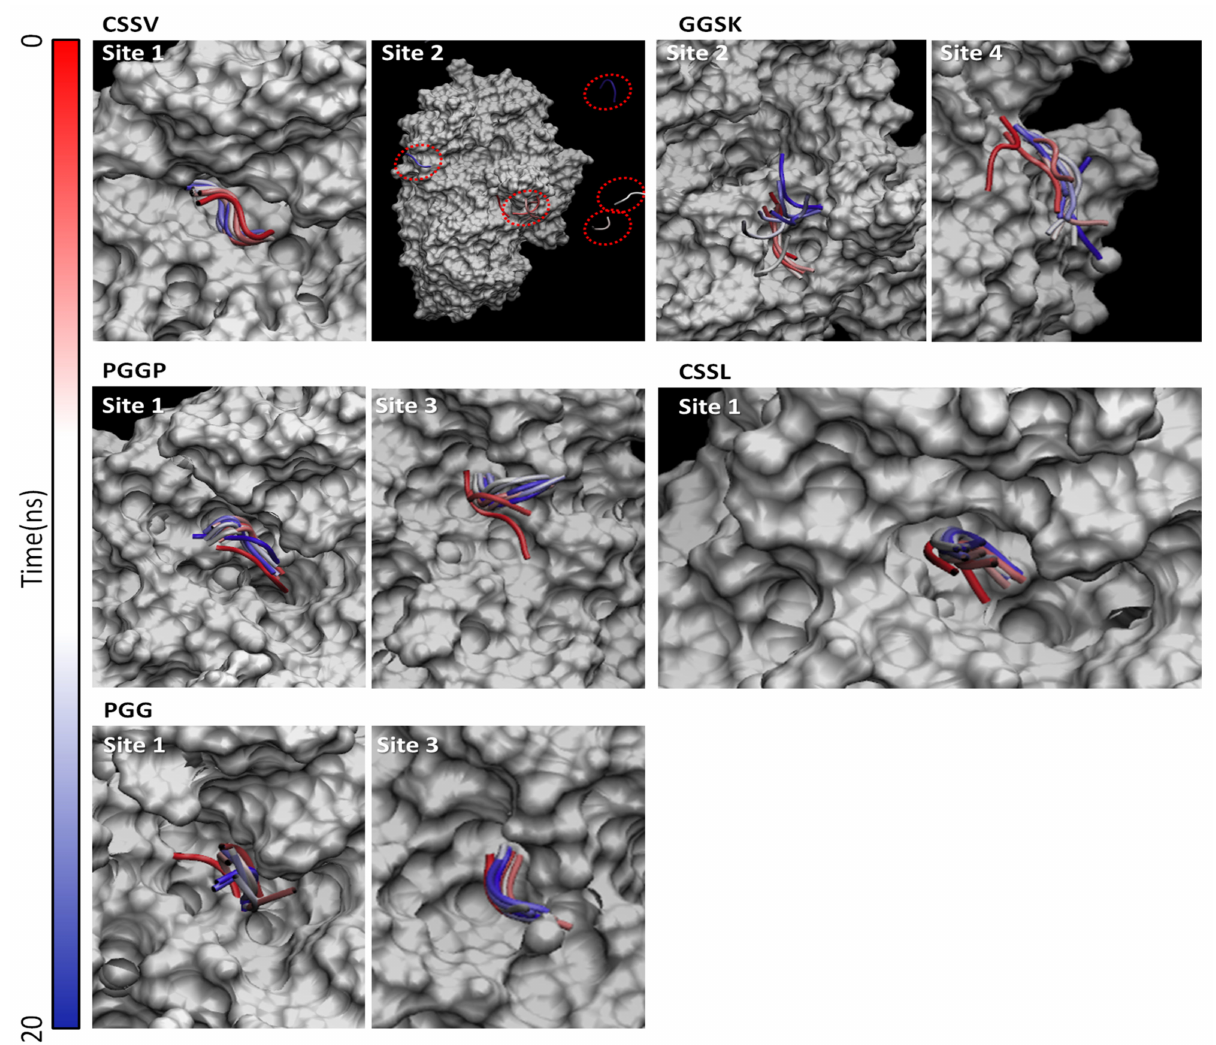
Figure 2. Trajectories of peptides under investigation. The protein is represented as white surface, while peptides are represented as tubes. The red-to-blue color switch indicates the stepwise changes of coordinates over time. The red dashed circles indicate the detachment of CSSV from site